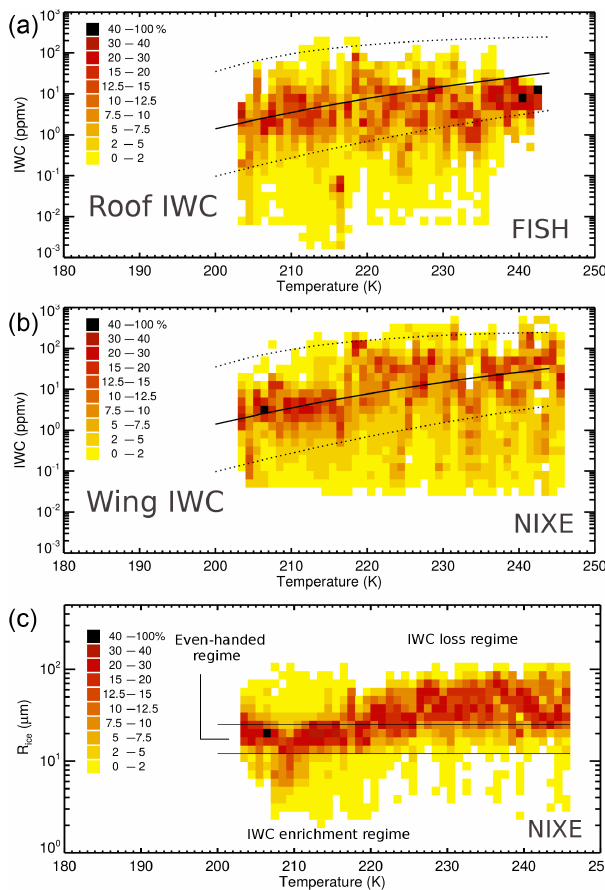
Figure 15. (a, b) IWC regarding temperature during ML-CIRRUS 2014, from roof-mounted FISH and wing-mounted NIXE (color code: frequencies of occurrence, black solid and dashed lines: median, core min. and max. IWCs after Schiller et al., 2008). (c) R ice regarding temperature during ML-CIRRUS 2014, from wing-mounted NIXE (the black lines denote the size regimes where ice particles are lost, enriched or both; for details see Sect.